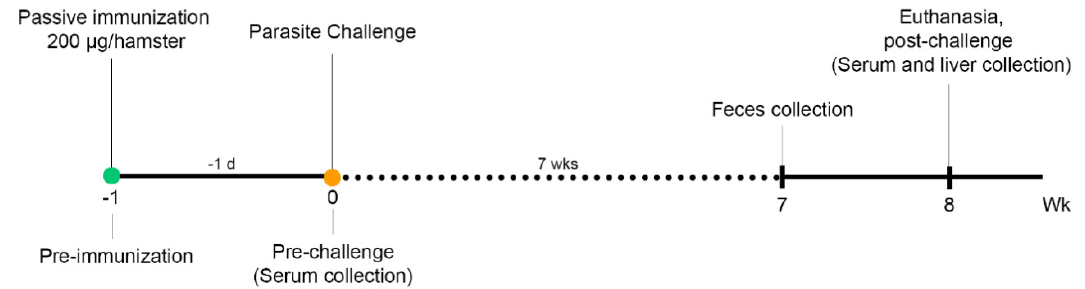
Figure 2. Schematic representation of the hamster vaccination and challenge